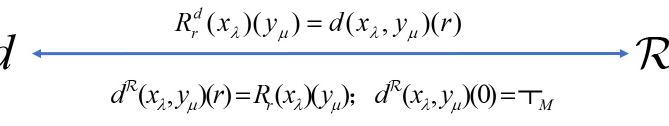
Figure 1. Relationship between d and R